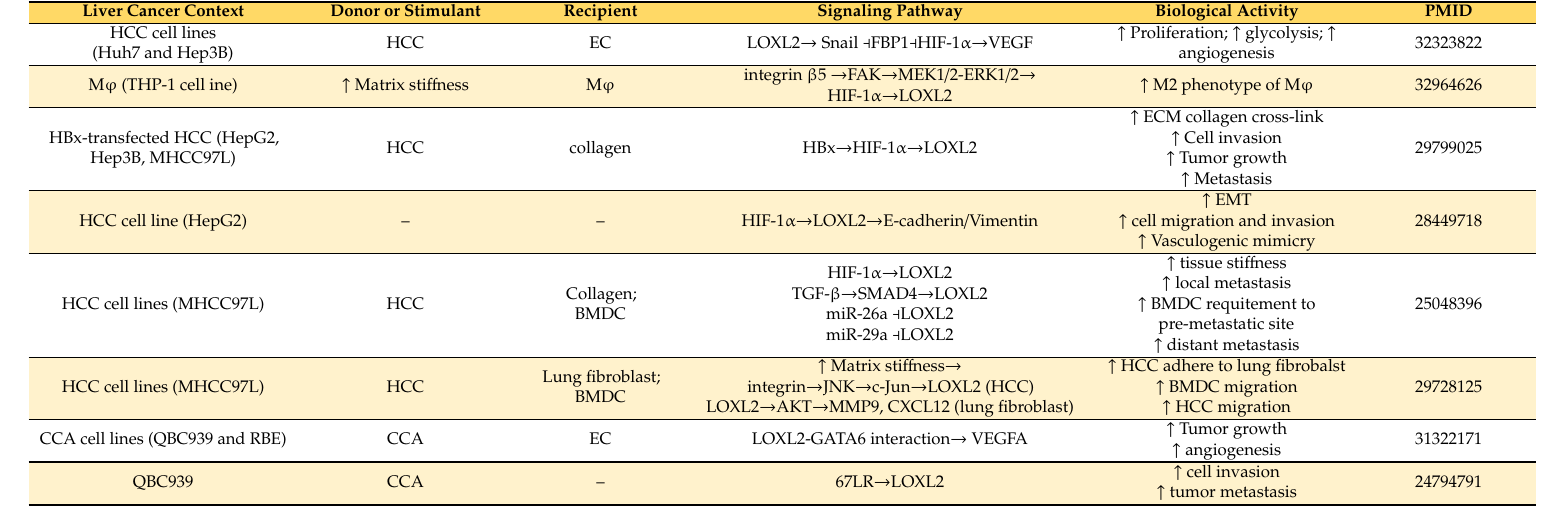
Table 3. Roles and mechanisms of LOXL2 in the hepatocarcinogenic